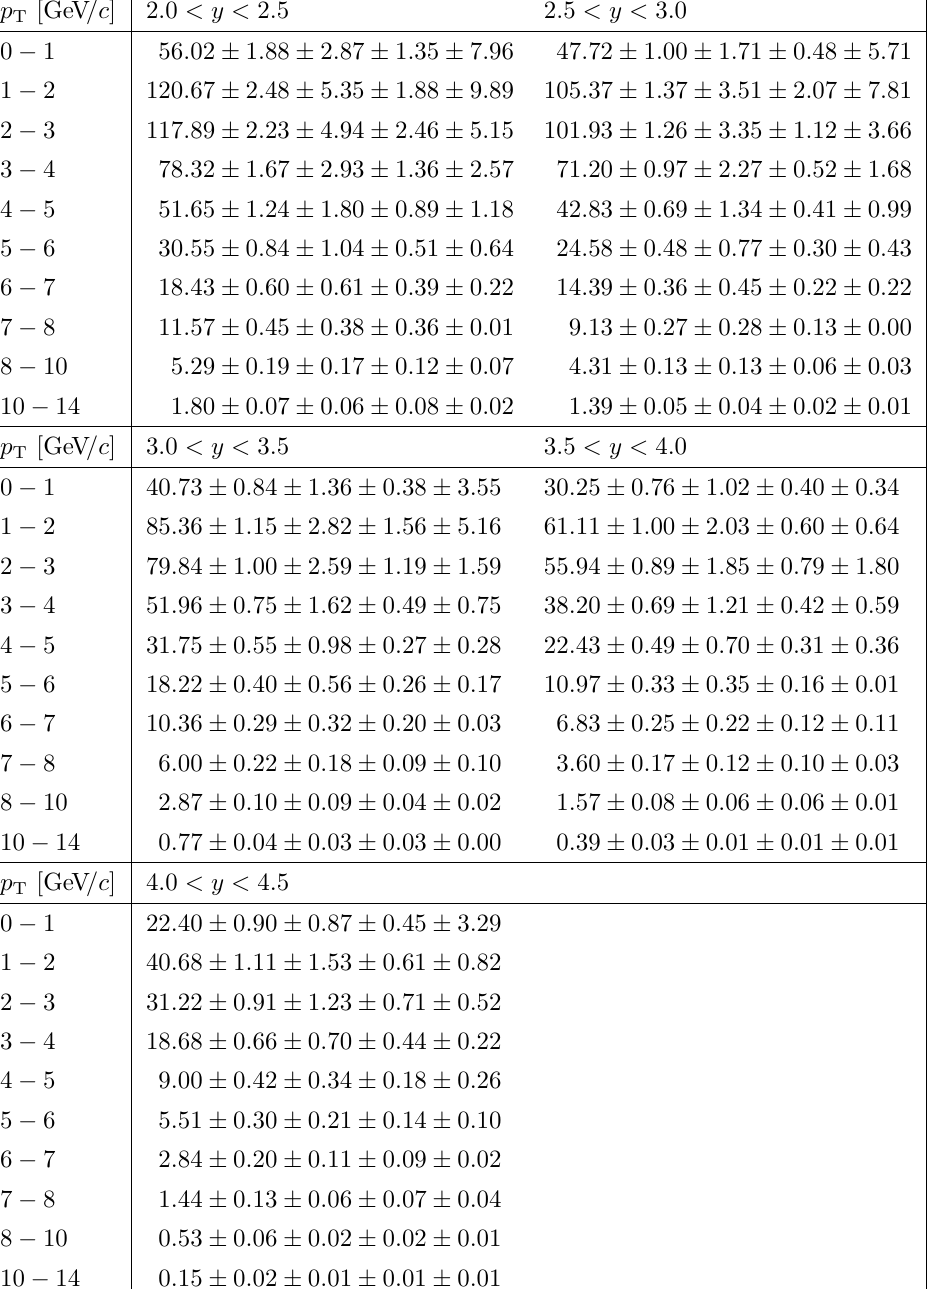
Table 3 . Double-differential production cross-sections nonprompt J/ψ mesons in ( p T , y ) intervals. The first uncertainties are statistical, the second are correlated systematic uncertainties shared between intervals, the third are uncorrelated systematic uncertainties, and the last are correlated between p T intervals and uncorrelated between y